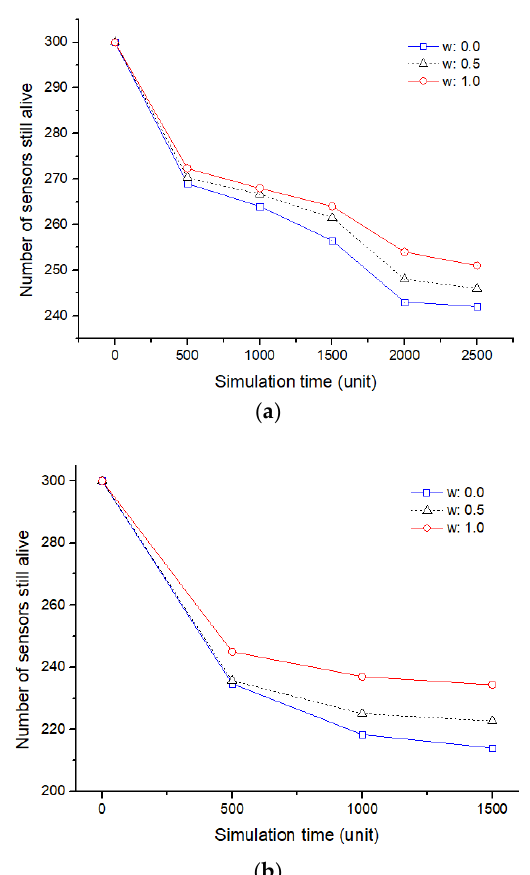
Figure 13. The number of total hopping sensors still alive: ( a ) A single sensing hole occurred; ( b ) two sensing holes occurred.